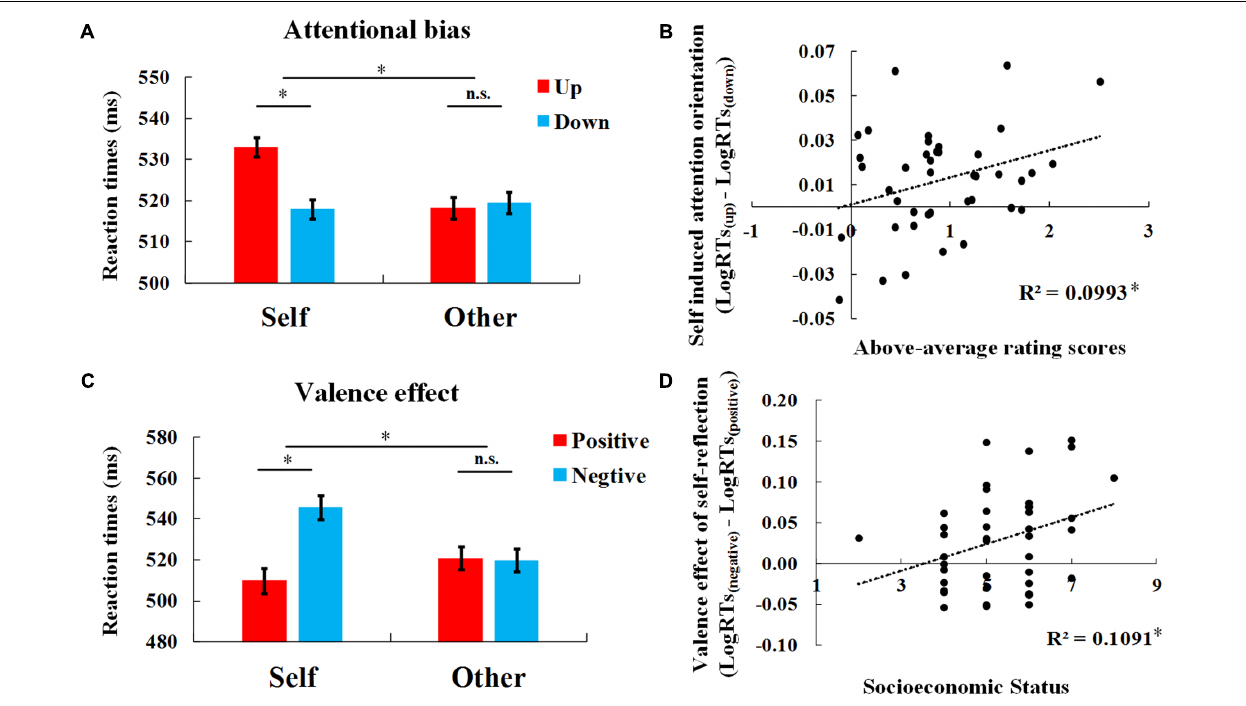
FIGURE 3 | Results of Study 2. (A) RTs to targets at up and down positions after reflection. The RTs are reported in raw millisecond values to facilitate comprehension. Error bars represent within-subject standard error of the mean. (B) Correlation between downward attention orientation effects (lgRT up − lgRT down ) after self-reflection and above-average scores. (C) RTs to targets after positive and negation reflection. The RTs are reported in raw millisecond values to facilitate comprehension. Error bars represent within-subject standard error of the mean. (D) Correlation between valence effect of self-reflection (lgRT negative − lgRT positive ) and subjective SES. ∗ p <